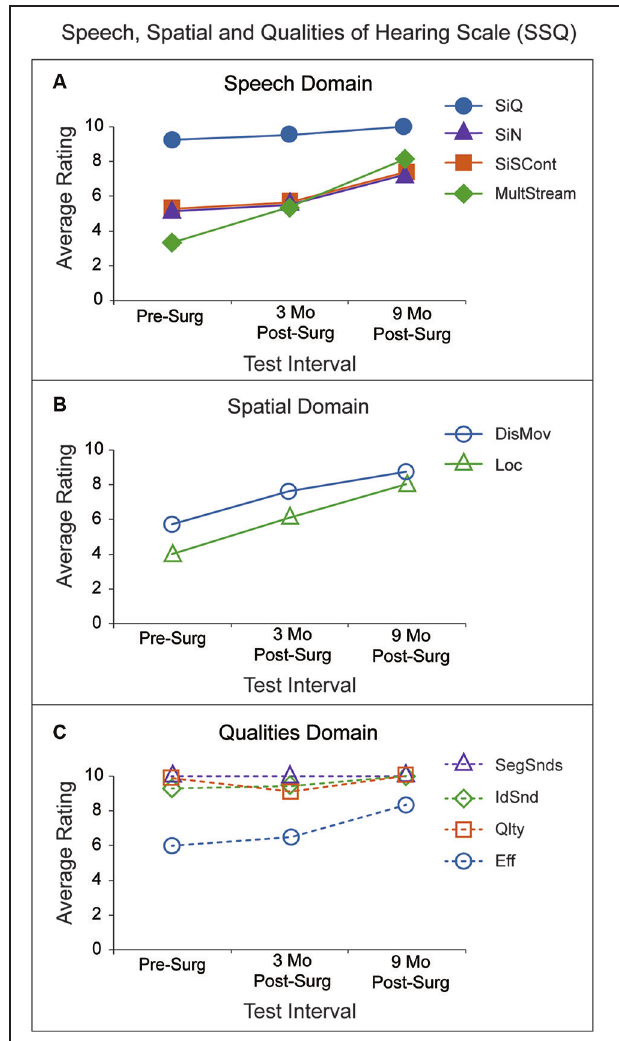
FIGURE 6 | SSQ ratings ( y -axis) for 10 subscales are divided into three domains and plotted for each test interval ( x -axis) . Panel A (Speech Domain) has P1’s average ratings for questions assessing four subscale areas: Speech in Quiet (SiQ; blue circles), Speech in Noise (SiN; purple triangles), Speech in Speech Contexts (SiSCont; orange squares), and Multiple Speech Stream Processing and Switching (MultStream; green diamonds). P1’s average ratings for questions assessing the two subscales within the Spatial Domain are shown in Panel B : Distance and Movement (DisMov; purple circles) and Localization (Loc; green triangles). Average subscale ratings within the Qualities Domain are indicated in Panel C : Segregation of Sounds (SegSnds; purple triangles), Identification of Sound and Objects (IdSnd; green diamonds), Sound Quality and Naturalness